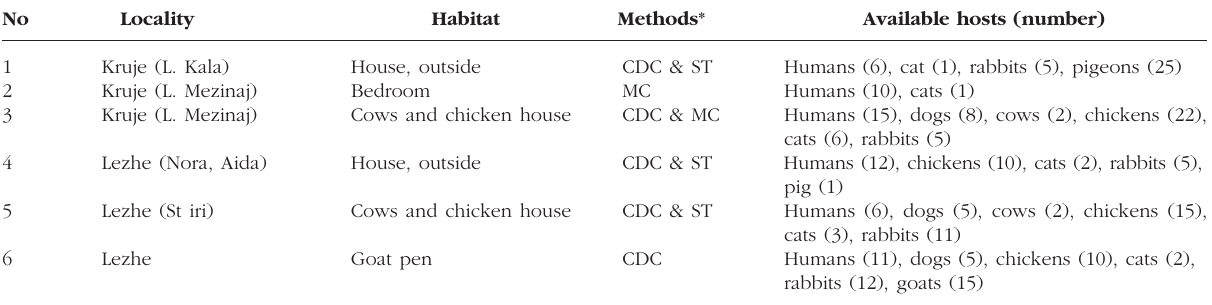
Table I. – Characteristics of the collecting sites: locality, resting site monitored, collecting methods and list of available hosts within a range of 50